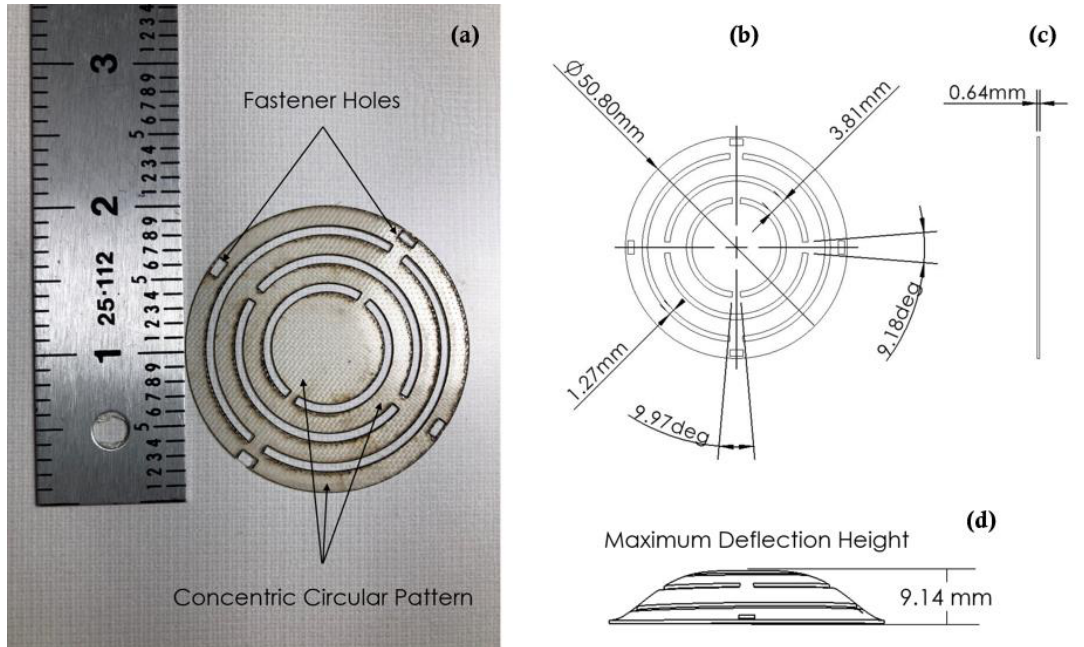
Figure 6. Design and fabrication of the FR4 Sensor diaphragm: ( a ) Fabricated sensor diaphragm next to a scale, ( b ) CAD model top view and dimensions of the sensor diaphragm, ( c ) CAD model side view of the sensor diaphragm and, and ( d ) simulated CAD view of the deflected sensor diaphragm.